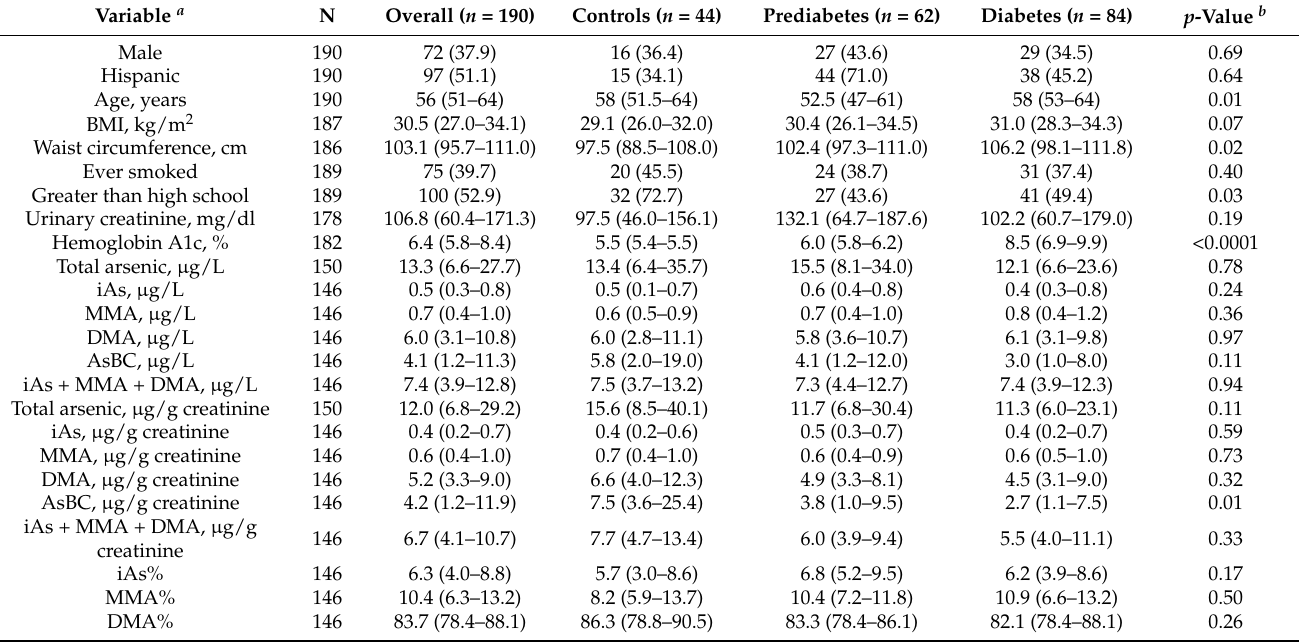
Table 1. Distribution of population characteristics by diabetes